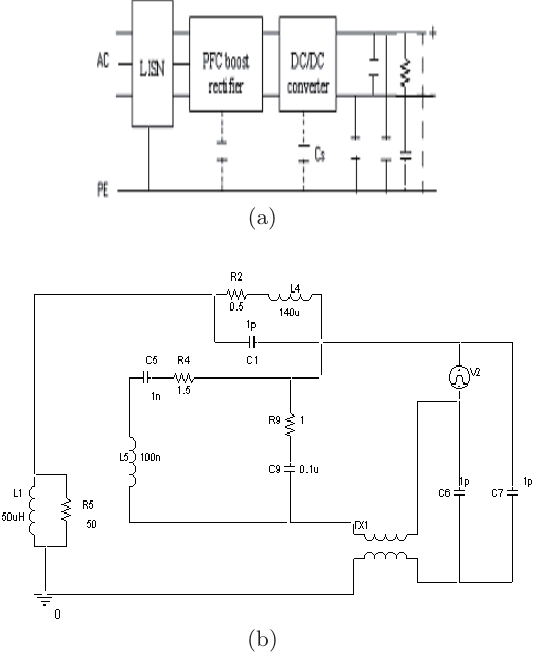
Fig. 6. Illustrations of the actual converter and the high fre- quency equivalent circuit model. (a) Actual circuit model. (b) Equivalent circuit model after adding damping components (RC).